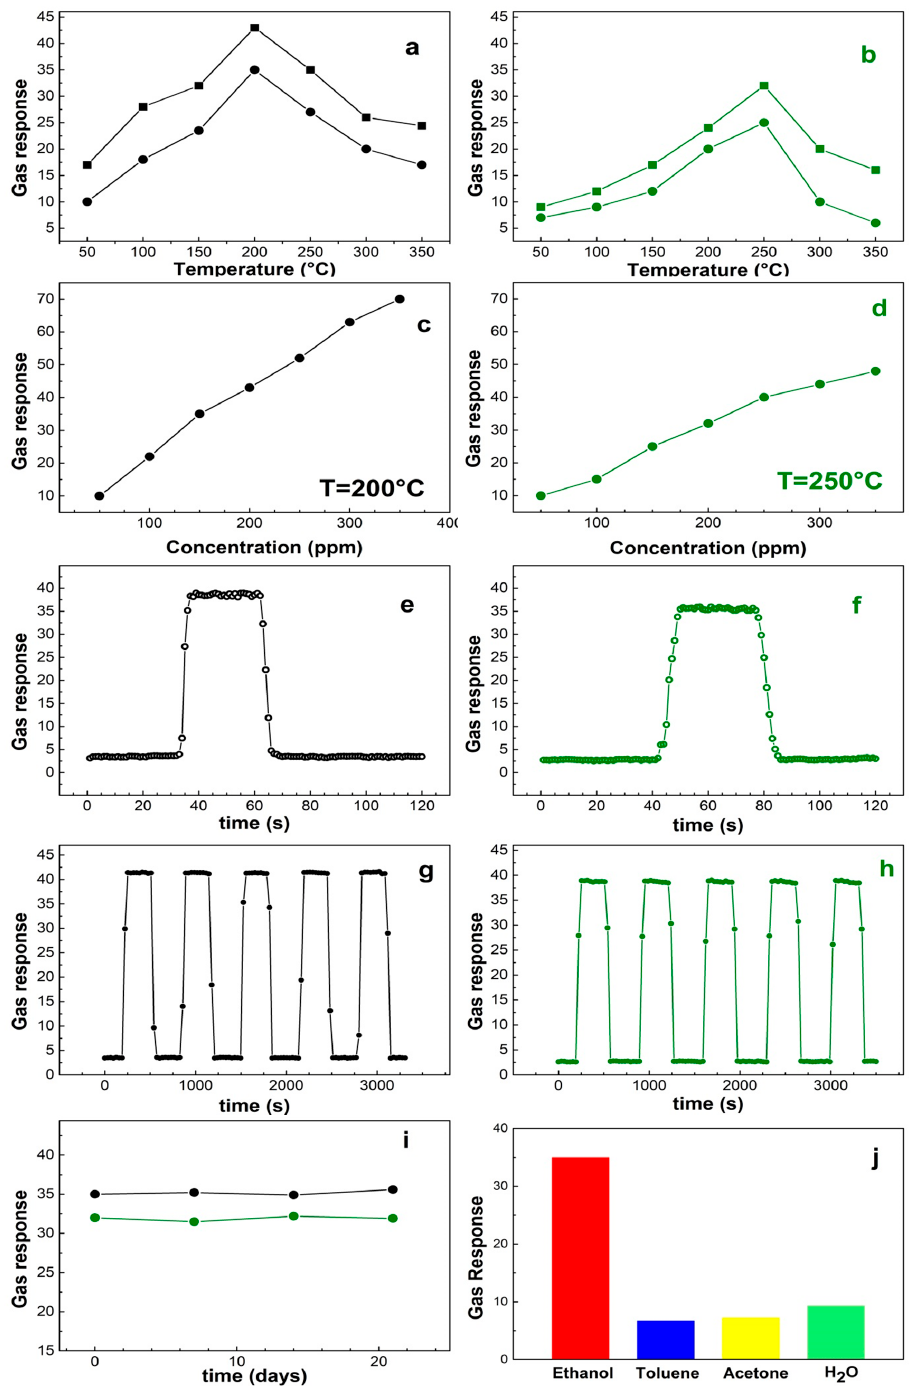
Figure 3. Plots of the gas responses. ( a–h ): the left panels correspond to grained-flower NiO, the right ones to the NiO nanoparticles. ( a , b ) are the gas response vs. temperature of sensors exposed to 150-ppm (solid dots) and 200-ppm (solid squares) ethanol, respectively. The gas responses vs. concentration are reported at 200 ◦ C for the grained-flower ( c ) and 250 ◦ C for the nanoparticles ( d ). ( e , f ) are response / recovery time; ( g , h ) repetitivety over time. Panel ( i ) is the response of the grained-flower sensor (black line) at 200 ◦ C to 150-ppm ethanol and nanoparticles sensor (green line) to 200-ppm ethanol at 250 ◦ C, over time (3 weeks) and ( j ) the response of the grained-flower sensor at 200 ◦ C to 150-ppm ethanol, toluene, acetone, and